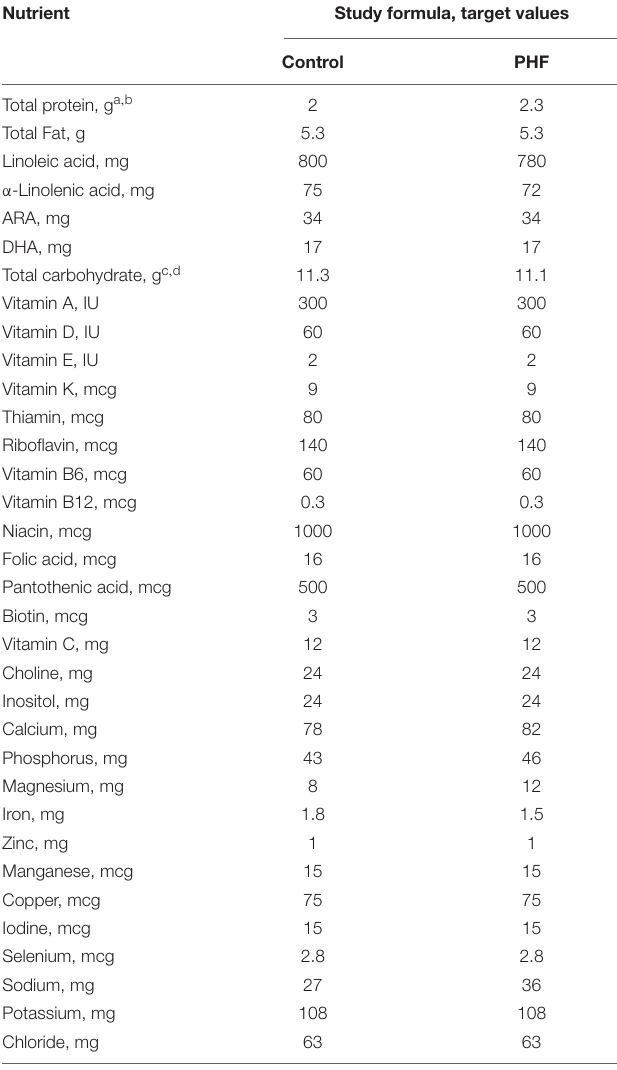
TABLE 2 | Nutrient composition per 100 kcal. Nutrient Study formula, target